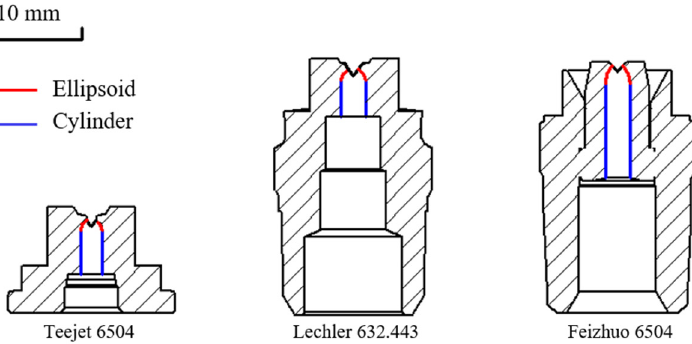
Figure 1. Sections showing the internal structure of the Teejet, Lechler, and Feizhuo nozzles.